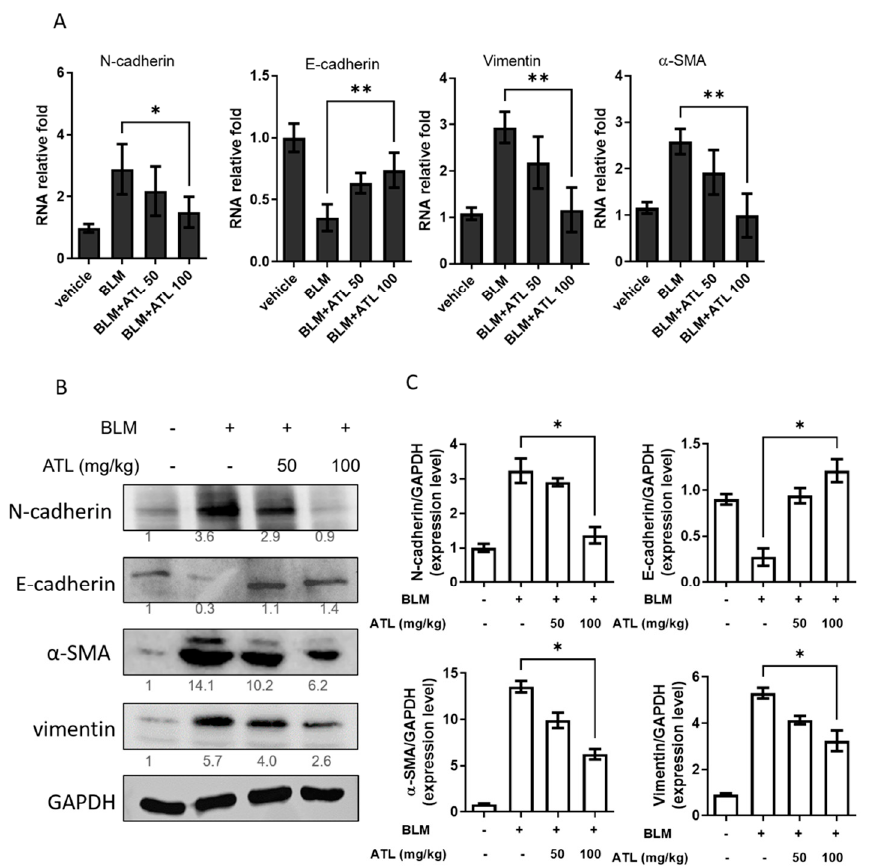
Figure 7. Atractylodin reduced BLM-induced EMT in mice pulmonary tissues. Lung tissue homogenates were collected on day 21 from each group of mice. ( A ) Relative mRNA expression levels of E-cadherin, α -SMA, and vimentin were measured with real-time PCR. ( B ) Protein expression levels of N-cadherin, E-cadherin, α -SMA, and vimentin were assessed with Western blot assay. ( C ) Quantitation of Western blot signal intensities by ImageJ software. Data are expressed as mean ± SEM of five mice in each group. (*) p < 0.05, and (**) p < 0.01 versus vehicle-treated BLM model group (as control group), as determined by non-parametric Kruskal–Wallis test and all pairwise multiple comparison procedures (Dunn’s Method).